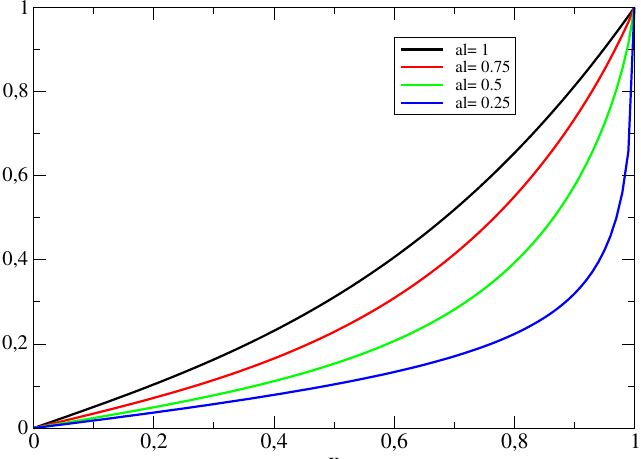
Figure 1. Distribution of the substrate at t = 0.5 for different fractional power parameters α = 1,0.75,0.5,0.25.